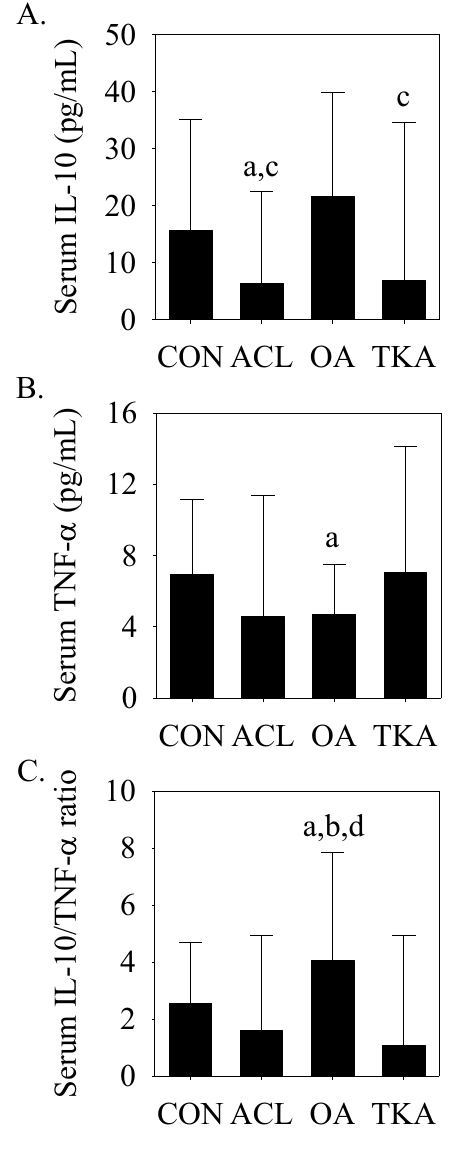
Figure 1. Serum IL-10 and TNF-α concentrations and the serum IL-10/TNF-α ratio in the CON, ACL, OA, and TKA groups. ( A ) Serum IL-10 concentrations were significantly lower in the ACL ( a p < 0.05 vs. CON and c p < 0.05 vs. OA) and TKA ( c p < 0.05 vs. OA) groups. ( B ) Serum TNF-α concentrations were significantly ( a p < 0.05 vs. CON) lower in the OA group. ( C ) The serum IL-10/TNF-α ratio was significantly ( a p < 0.05 vs. CON, b p < 0.05 vs. ACL, and d p < 0.05 vs. TKA) higher in the OA group. Data presented as median (interquartile